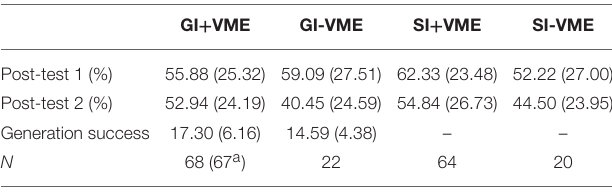
TABLE 3 | Means and standard deviations (in parentheses) of performance assessed in post tests 1 and